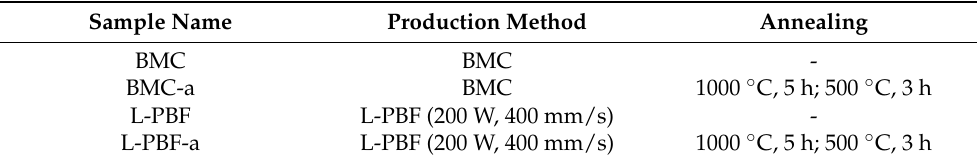
Figure 1. Fe73.8-Pr20.5-Cu2.0-B3.7 powder: ( a ) Powder used in the L-PBF process (scanning electron microscopy image, backscatter electron detector). A higher magnification image of the powder is shown as inset of ( a ). ( b ) Particle size distribution (cumulative distribution Q3 , distribution density q3 ) of the powder using laser diffraction. The values of d25 , d50 and d90 are also listed. Table 1. Overview of FePrCuB sample nomenclature, production method and sample state. Sample nomenclature is chosen according to the production route. Cast magnet materials are labeled BMC for book-mold casting; samples produced by laser powder bed fusion are labeled L-PBF for selective laser melting. Annealed samples are denoted with an additional “-a”.